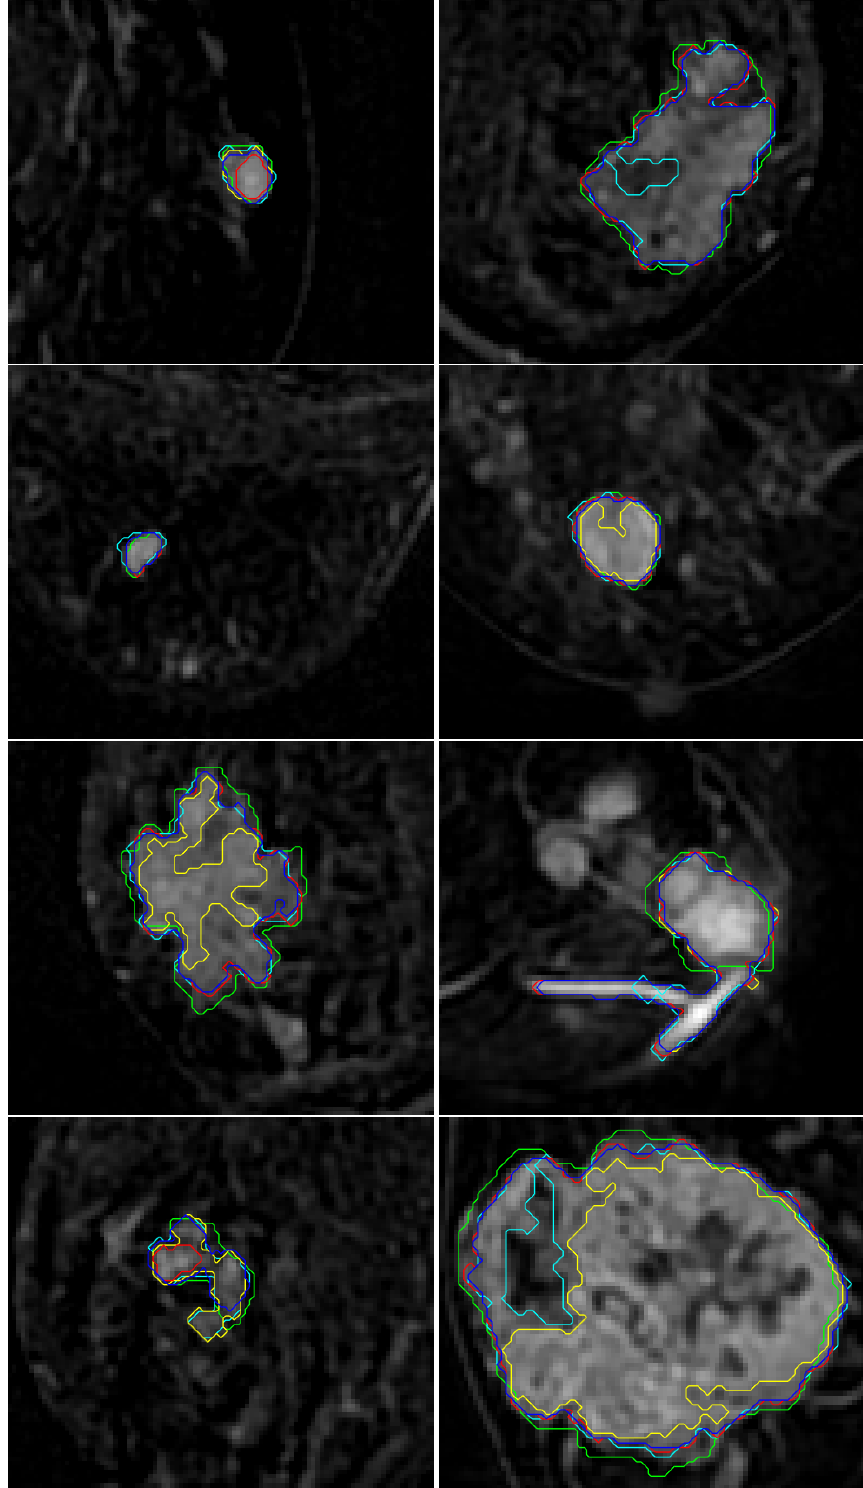
Figure 10. Examples of interesting segmentation results showing FPs and FNs. In particular, the examples compare results yielded by the four investigated unsupervised method—namely, SMRG (cyan), k-means (yellow), FCM (red), sFCM (blue)—against the ground-truth